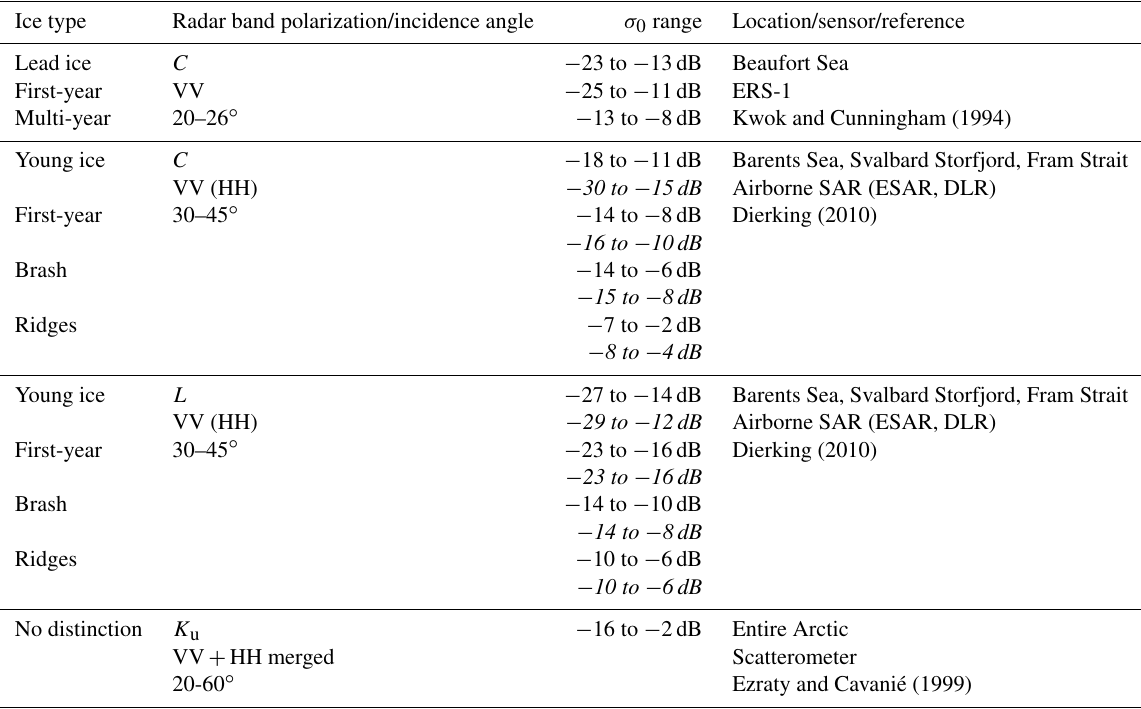
Table 3. Ranges of backscattering coefficients σ 0 for different sea ice types, with examples. Numbers given in italics are for HH polarization. Ice type